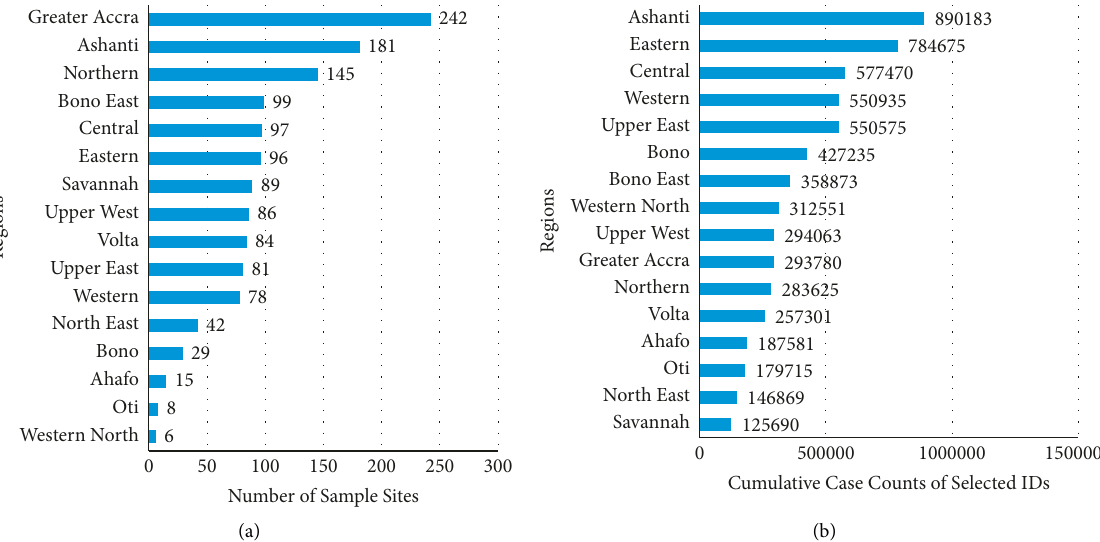
Figure 3: (a) The regional breakdown of the peer-reviewed articles on surveillance of the spectrum of IDs in Ghana. (b) The regional breakdown of cumulative case counts of selected IDs across the country. These IDs are the highest reported cases of their pathogens at health facilities and include typhoid fever, malaria, and influenza-like Table 5: The breakdown of peer-reviewed surveillance research of endemic or potentially endemic infectious diseases in Ghana from 2000 to 2020. The table indicates for each category the type of district (district, municipal, and metropolitan), the number of pathogens studied, the number of areas the studies were carried out, and the number of times the studies were conducted. P : pathogens studied; A : areas studied; T : number of times the studies were carried out.